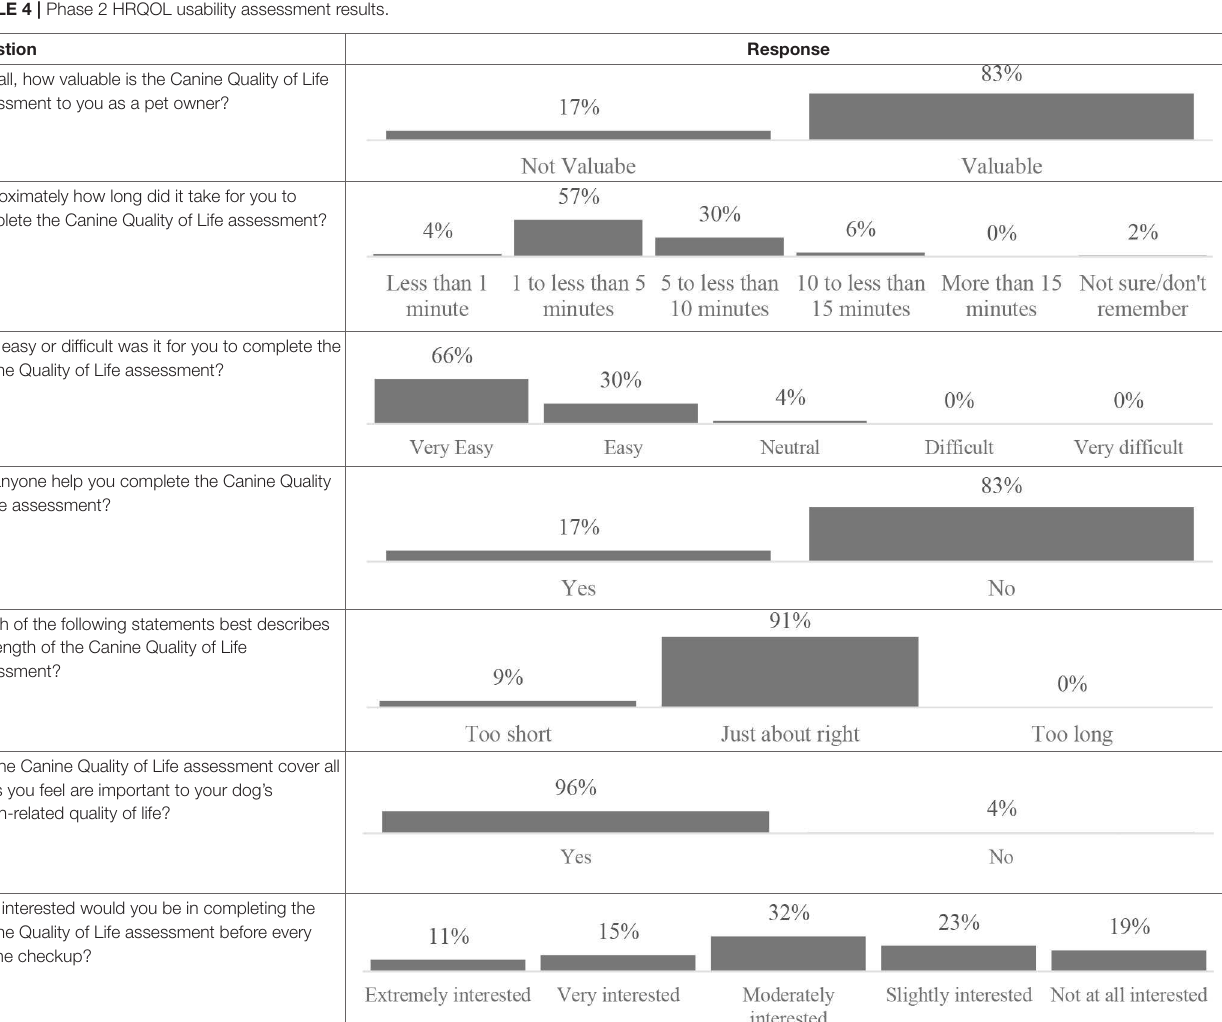
TABLE 4 | Phase 2 HRQOL usability assessment